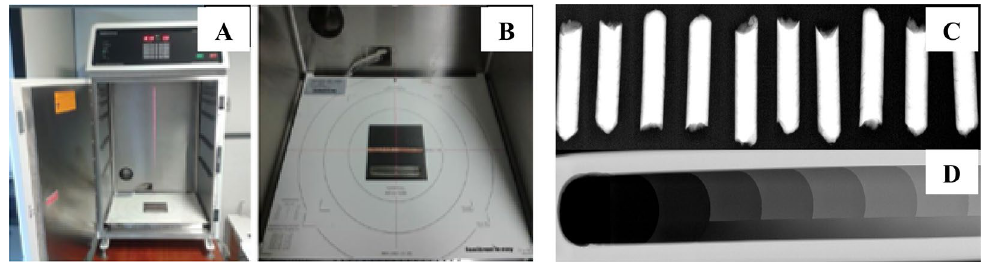
Figure 3. X-ray densitometry. ( A ) Faxitron model LX-60 cabinet X-ray system. ( B ) Shielded X-ray compartment. ( C ) Pellets. ( D ) Cellulose acetate calibration